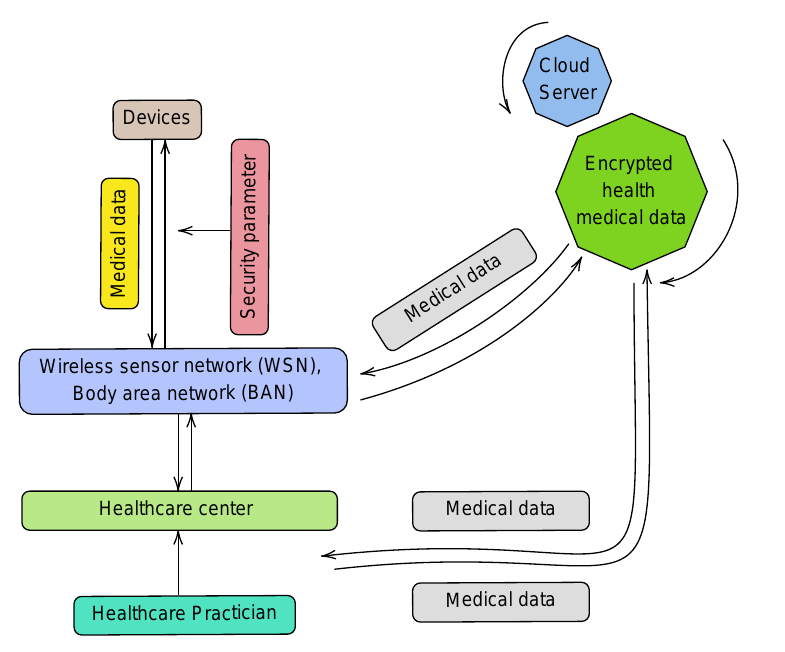
Figure 10. Cloud-based